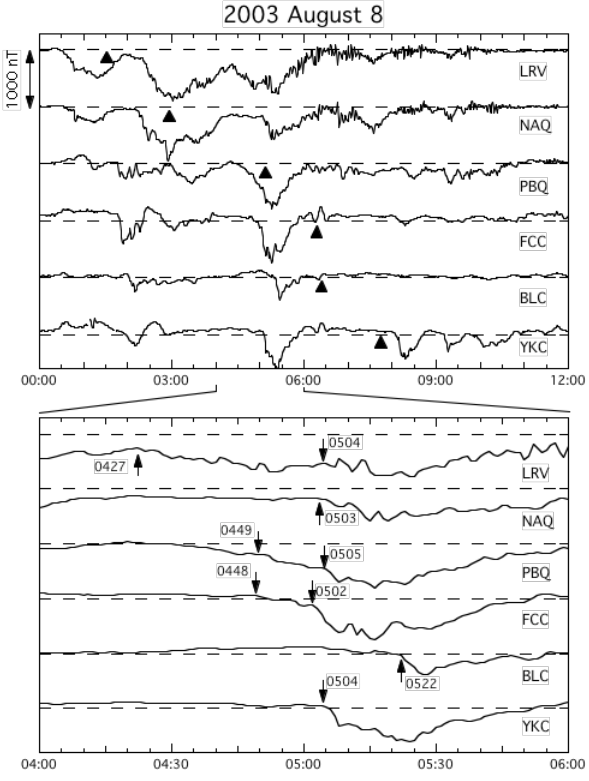
Figure 2 Fig. 2. The X-component of magnetic field from ground-based magnetometers. The bottom plot contains the same set of mag- netic stations with the same vertical scale but for a shorter time span (04:00–06:00 UT).